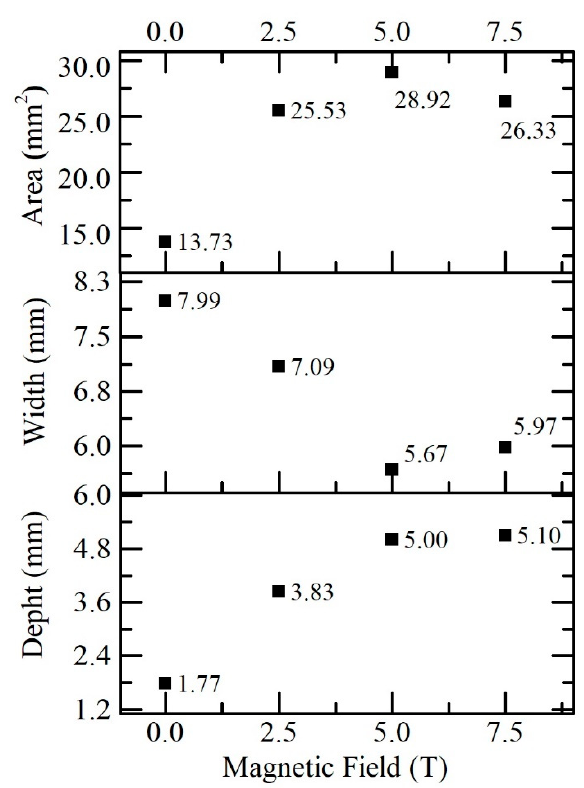
Figure 4. Variations in the magnetic field versus fusion zone (FZ) geometry.